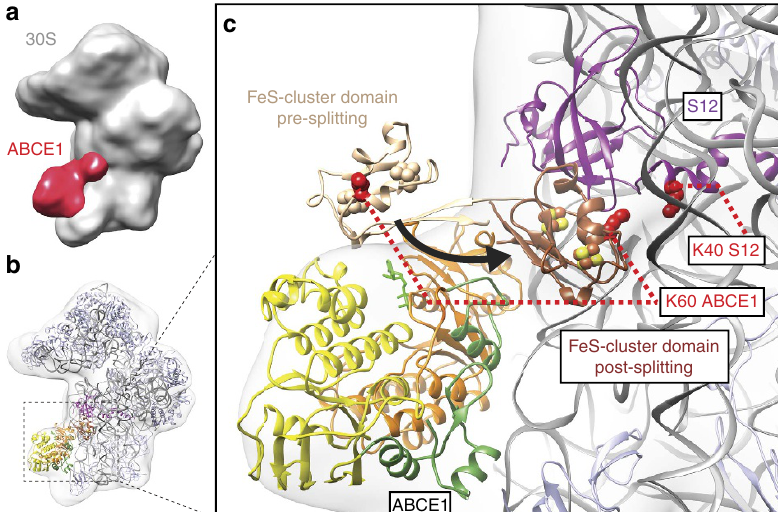
Figure 4 | Low-resolution cryo-EM structure of the 30S (cid:2) ABCE1 post-splitting complex. ( a ) Overview of the 30S (cid:2) ABCE1 post-splitting complex electron density map low-pass filtered at B 25Å. The final 30S (cid:2) ABCE1 data set contained 19,500 particles and the final resolution was 17Å (Fourier shell correlation 0.5). The ABCE1 extra density is shown in red. ( b ) Model of the 30S (cid:2) ABCE1 complex in post-splitting state showing the models of the P. furiosus small 30S subunit (grey; 4V6U) 52 and ribosome-bound ABCE1 (FeS cluster domain brown; NBD1 orange and NBD2 yellow; hinges 1 and 2 green, ADP-bound green; 3J15) 8 . The FeS cluster domain was fitted into the extra density located near ribosomal proteins S12 (purple). ( c ) Zoom-in showing the pre-splitting (wheat) and post-splitting (brown) state of the FeS cluster domain. The post-splitting state was modelled based on a specific inter-crosslink in XL-MS between lysine 60 of ABCE1 (lysine 64 in P. furiosus ) and lysine 40 of S12 (shown in red). Because of this conformation change, the C a –C a distance between these highly conserved lysines in Archaea, yeast and human is reduced from 59.5Å in the pre-splitting state to 17.5Å in the post-splitting